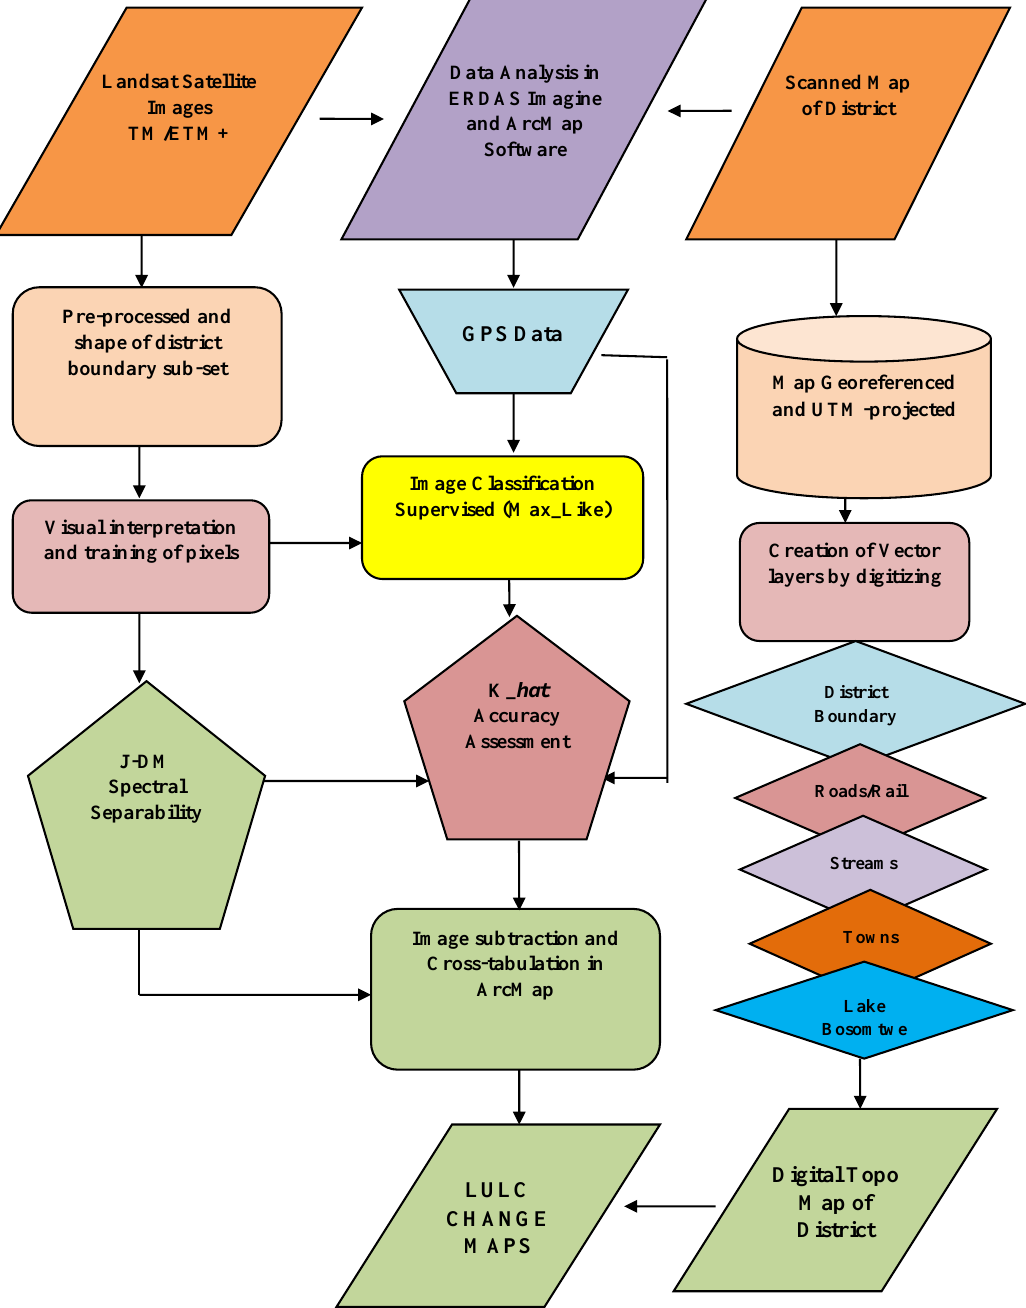
Figure 8. Methodological work flow in ERDAS Imagine and